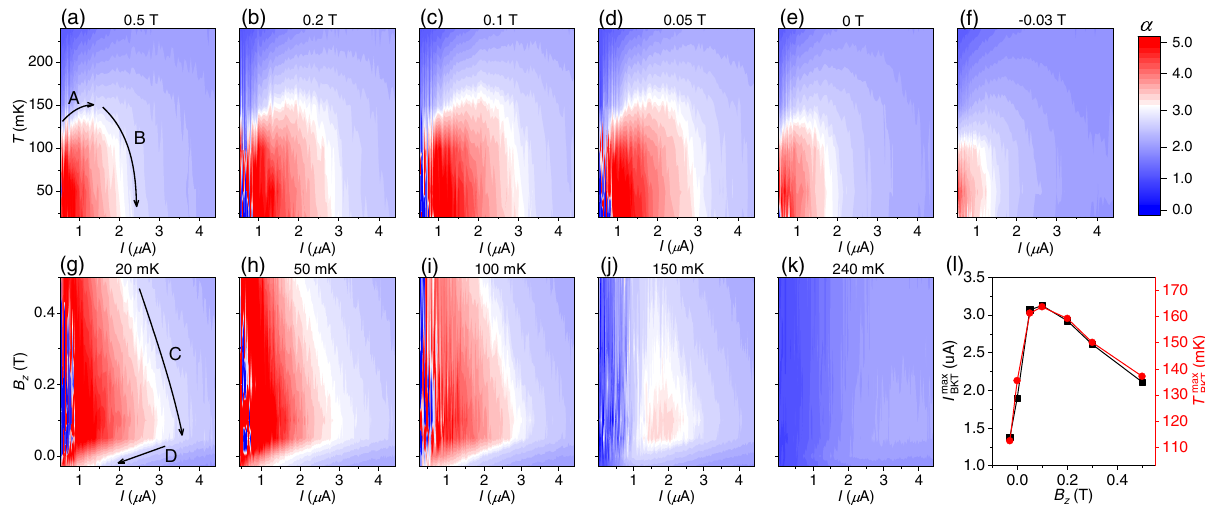
Fig. 3 Evolutions of BKT-like transitions parameterized by the applied current, magnetic fi eld, and temperature. a – f Color-plots of α as functions of I and T under given B z . g – k Color-plots of α as functions of I and B z under given T . The white contours show the situations with α = 3, the critical windows for the BKT-like transitions. The black arrows A, B in a and C, D in g indicate the evolutions by varying I and B z respectively. l The maxima of the critical current ( I max ) and temperature ( T max ) for BKT-like transitions as a function of B z , which are extracted by projecting α contours in a-f onto the I - and T -axes, BKT BKT